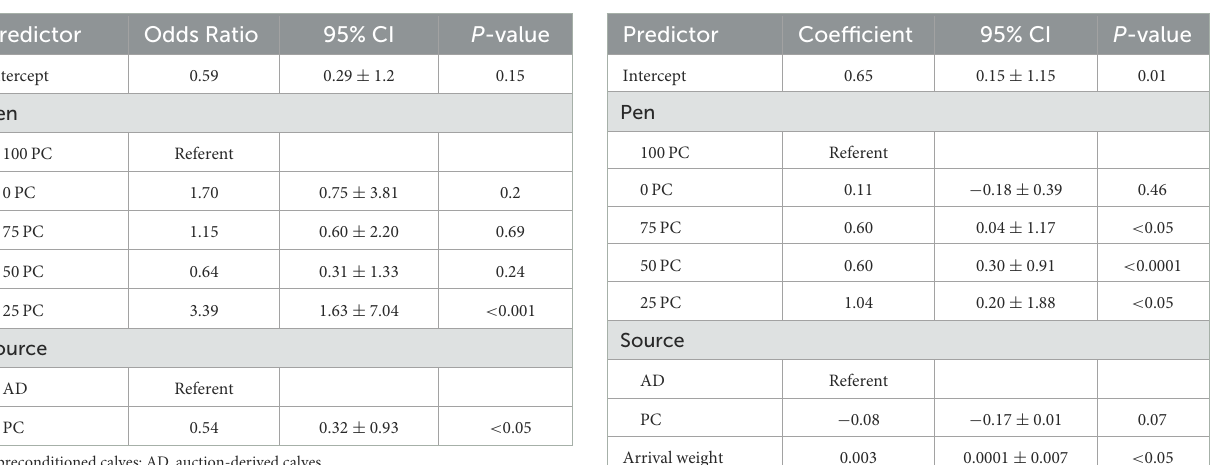
TABLE 3 Final multivariate linear regression model for average daily gain at pen level by source and arrival weight.